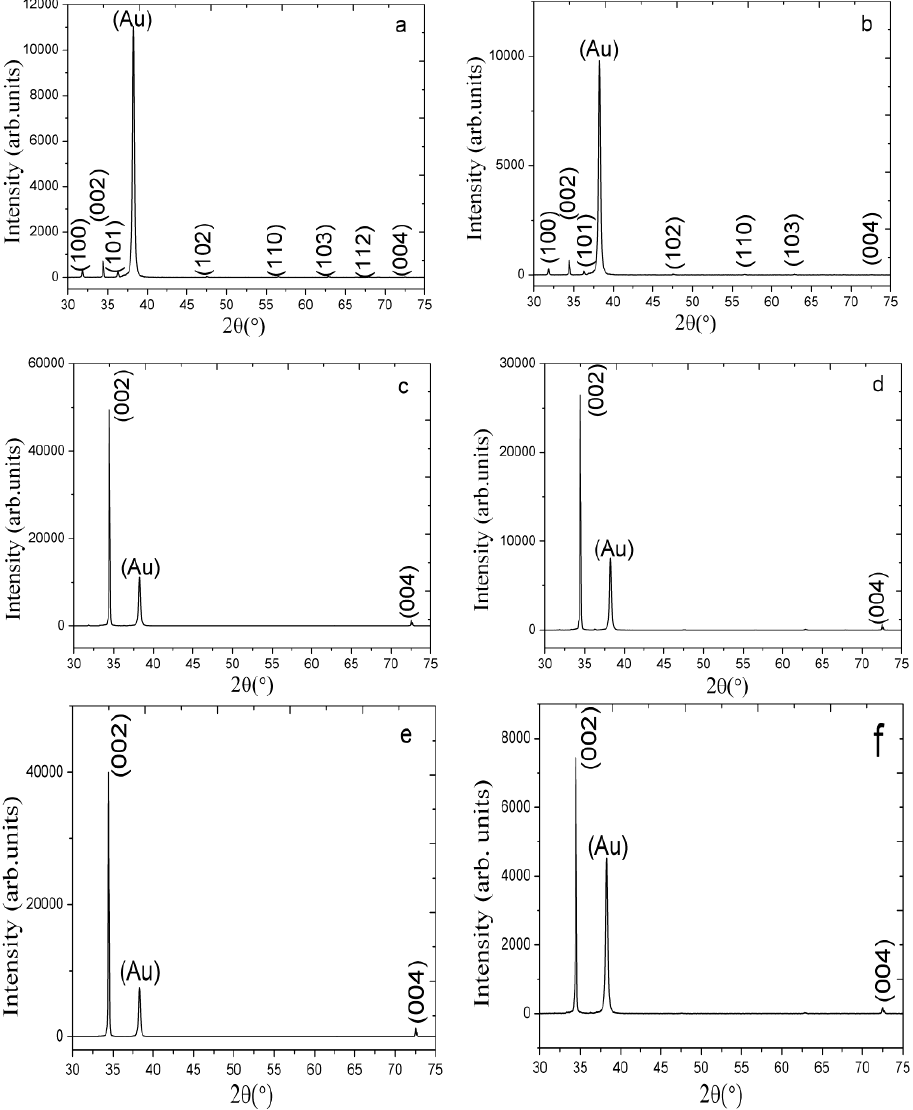
Figure 1. The XRD pattern of the ZnO nanorods grown using the seed solution of ZnO nanoparticles and chitosan with different amounts of ZnO nanoparticles ( a ) 0; ( b ) 10; ( c ) 30; ( d ) 50; ( e ) 70; and ( f ) 90